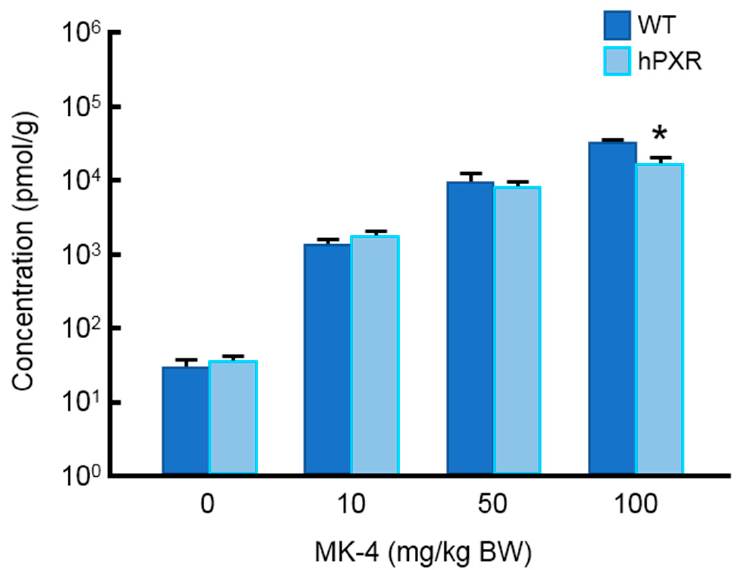
Figure 1. Menaquinone-4 concentration in the liver of wild-type and hPXR mice after treatment with menaquinone-4. Menaquinone-4 (10, 50, or 100 mg/kg of body weight) was given by oral gavage to wild-type (WT) and hPXR female mice. After 6 h, mice were sacrificed, and hepatic menaqinone-4 concentrations were quantitated by fluorescence HPLC. Data are expressed as the mean ± SEM, n = 4–9. * p < 0.05, compared to wild-type